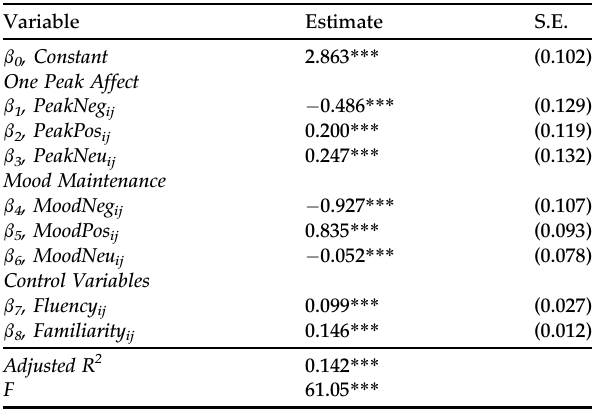
Table 2. Parameter estimates.